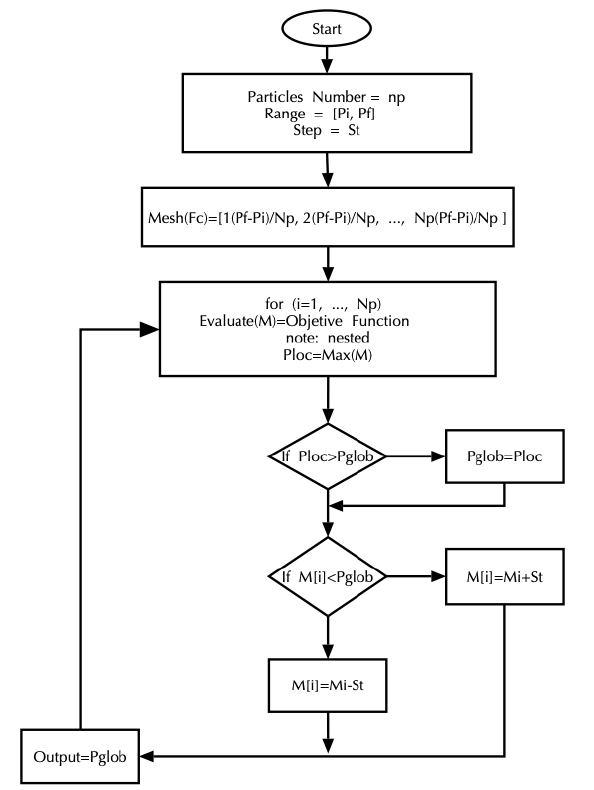
Figure 1. Generalized pattern search